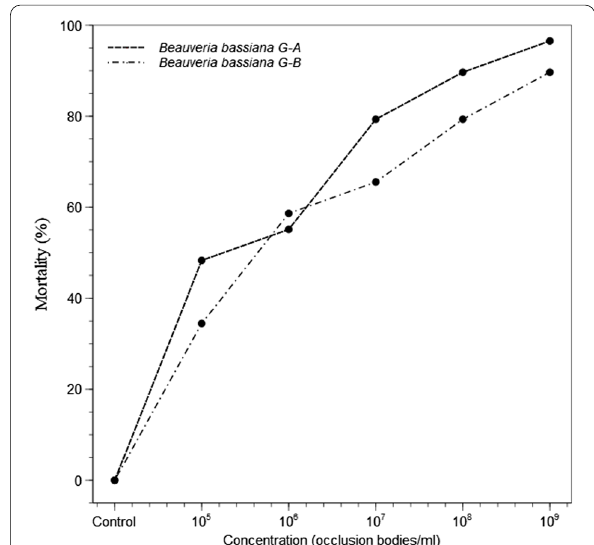
Fig. 3 Galleria mellonella larvae mortality after the administration of five spore concentration doses of G-A and G-B Beauveria bassiana isolates